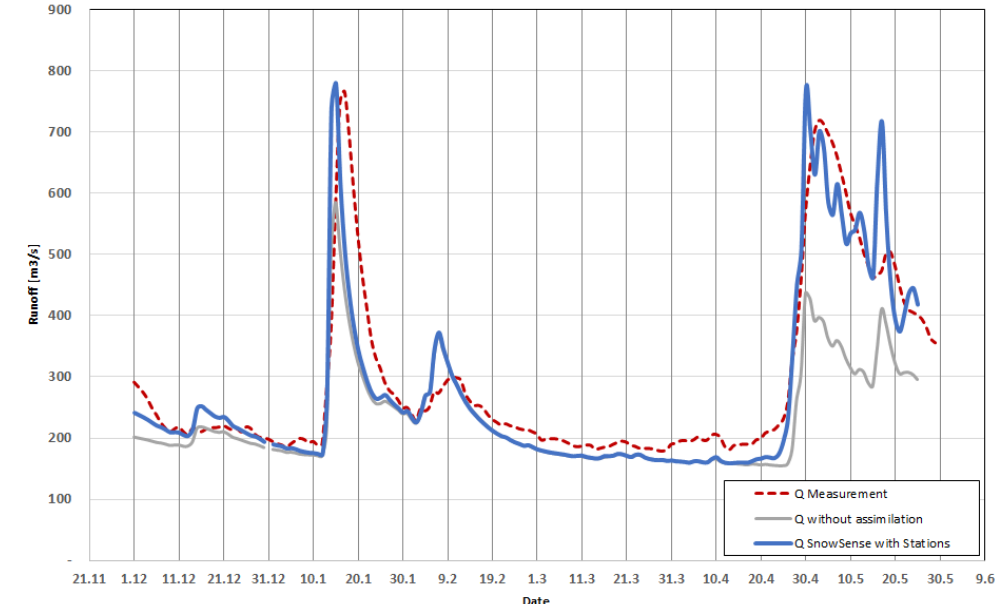
Figure 7. Daily run-off results from PROMET without (grey), with assimilation (blue) of stations and EO against the values (dashed red) measured at Humber Village (catchment: 7600 km 2 ) for the winter season